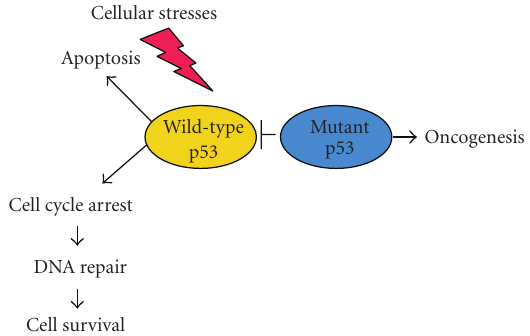
Figure 1: Dominant-negative e ff ect of mutant p53 on wild-type p53. In response to cellular stresses, wild-type p53 is activated and induces cell cycle arrest and/or apoptotic cell death. Mutant p53 binds to wild-type p53 and inhibits its tumor suppressor function, thereby promoting tumor